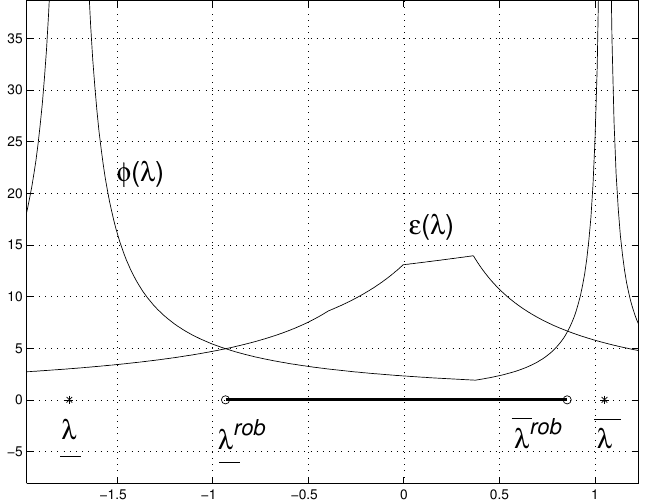
Figure 3. The robust boundary